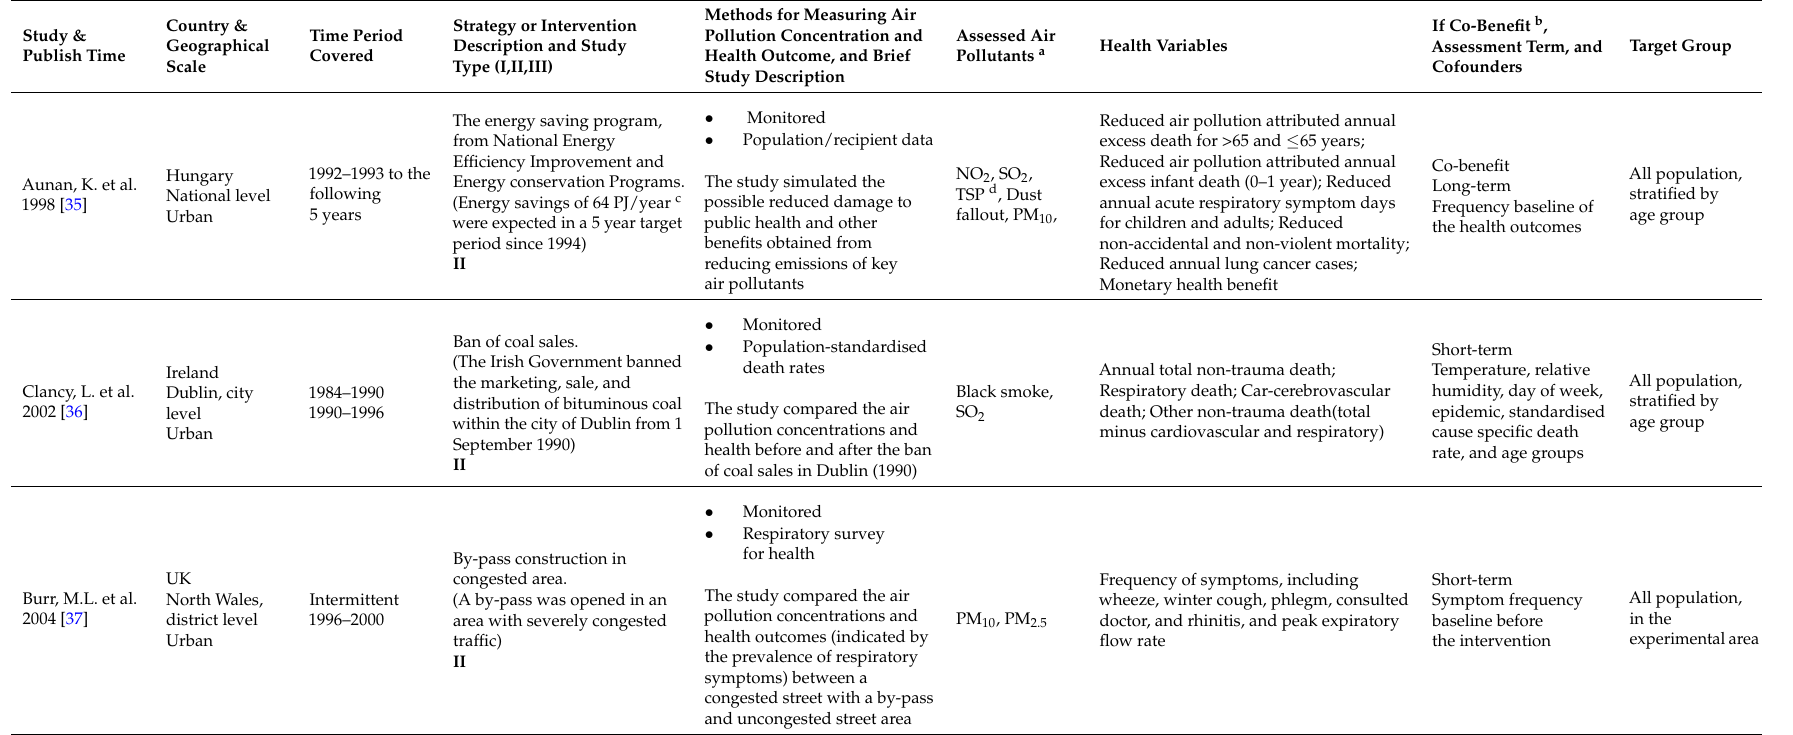
Table 2. Summary of the included